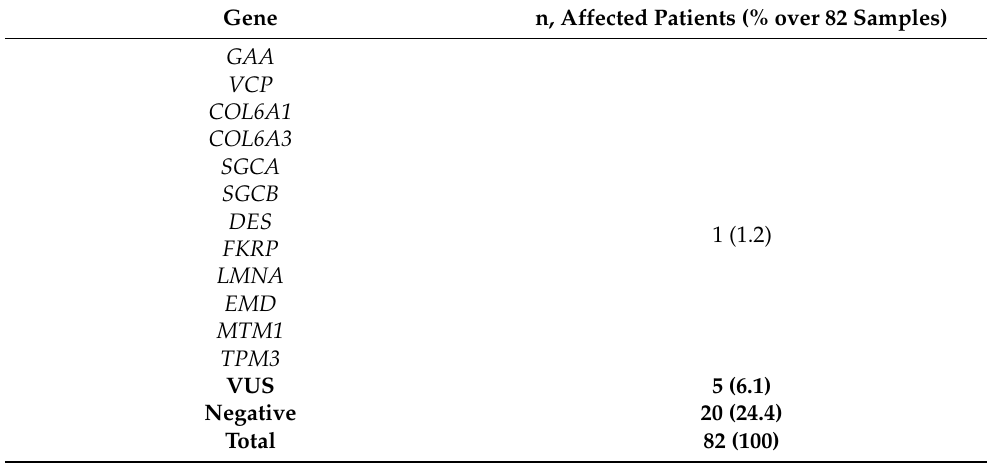
Table 2. Cont. Gene n, Affected Patients (% over 82